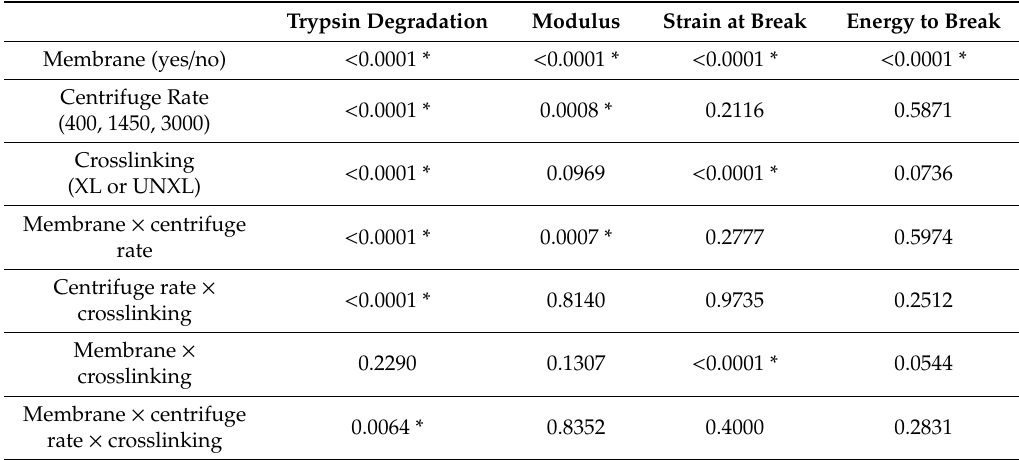
Table A1. ANOVA model results (* Statistically significant at 0.05 level).